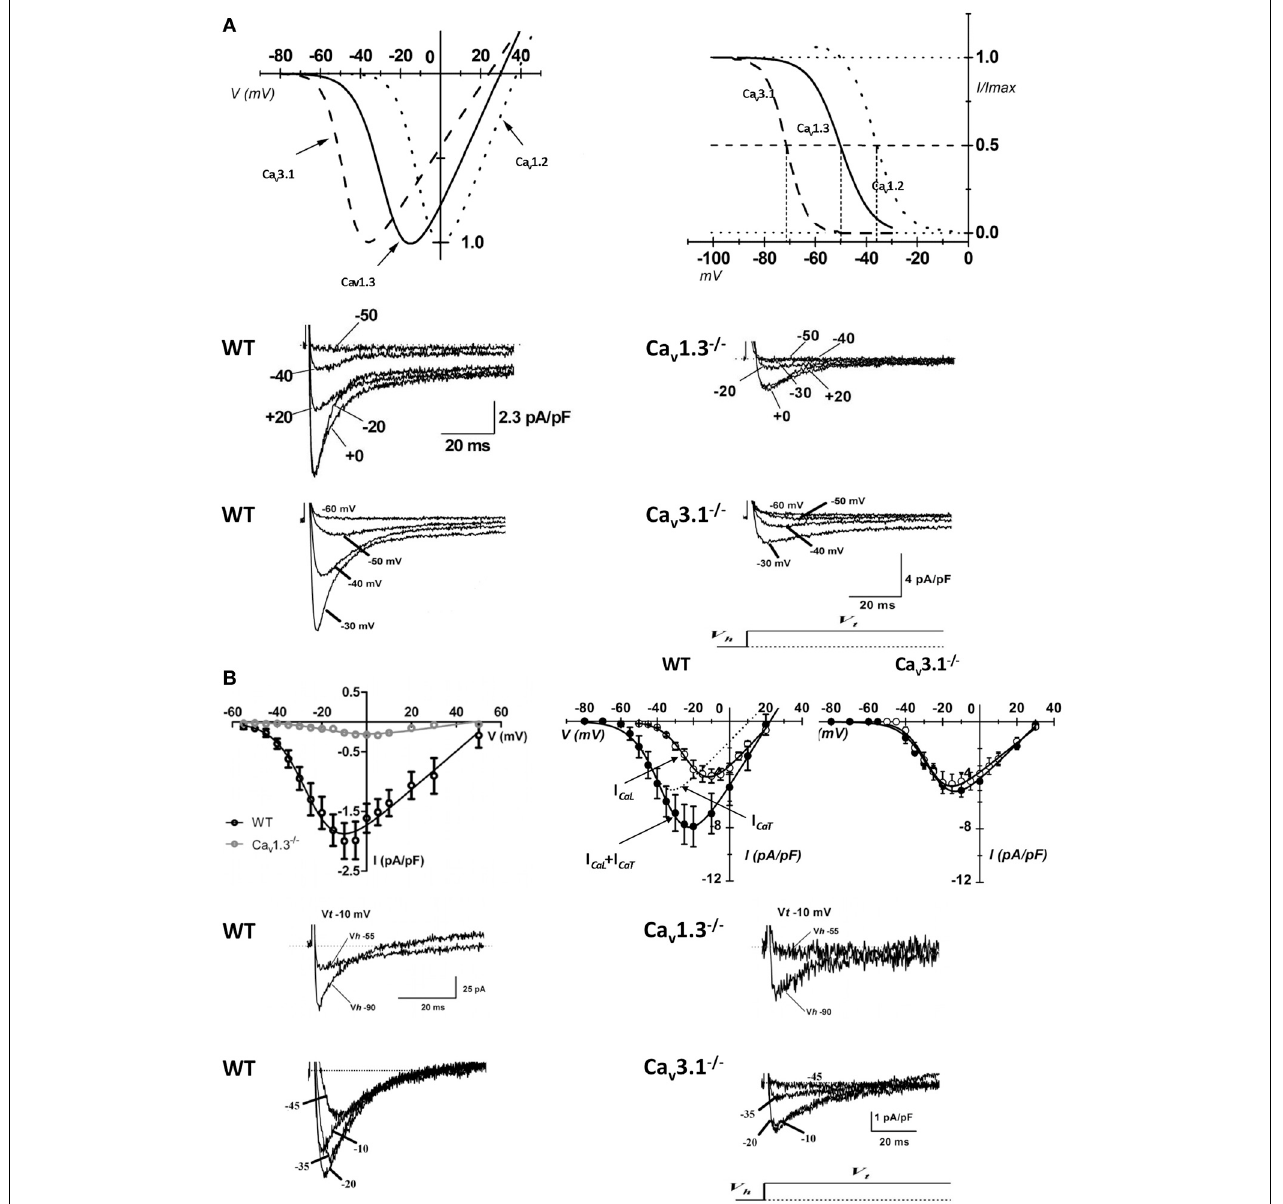
from WT (black open circles) and Ca v 1.3 − / − (gray open circles) isolated AVN cells. Top right panels: current to voltage relationship in isolated AVN cells from WT and Ca v 3.1 − / − mice. Sample traces of I Ca , L (middle panels) and I Ca , T (bottom panels) recorded in isolated AVN cells from WT, Ca v 1.3 − / − and Ca v 3.1 − / − mice. For I Ca , L recordings the holding potential (V h ) was set at − 55mV, for Ca v 3.1 at − 90mV. Test potential (V t ) is reported near the trace (reprinted from Mangoni et al., 2006b with permission from Wolters Kluwer